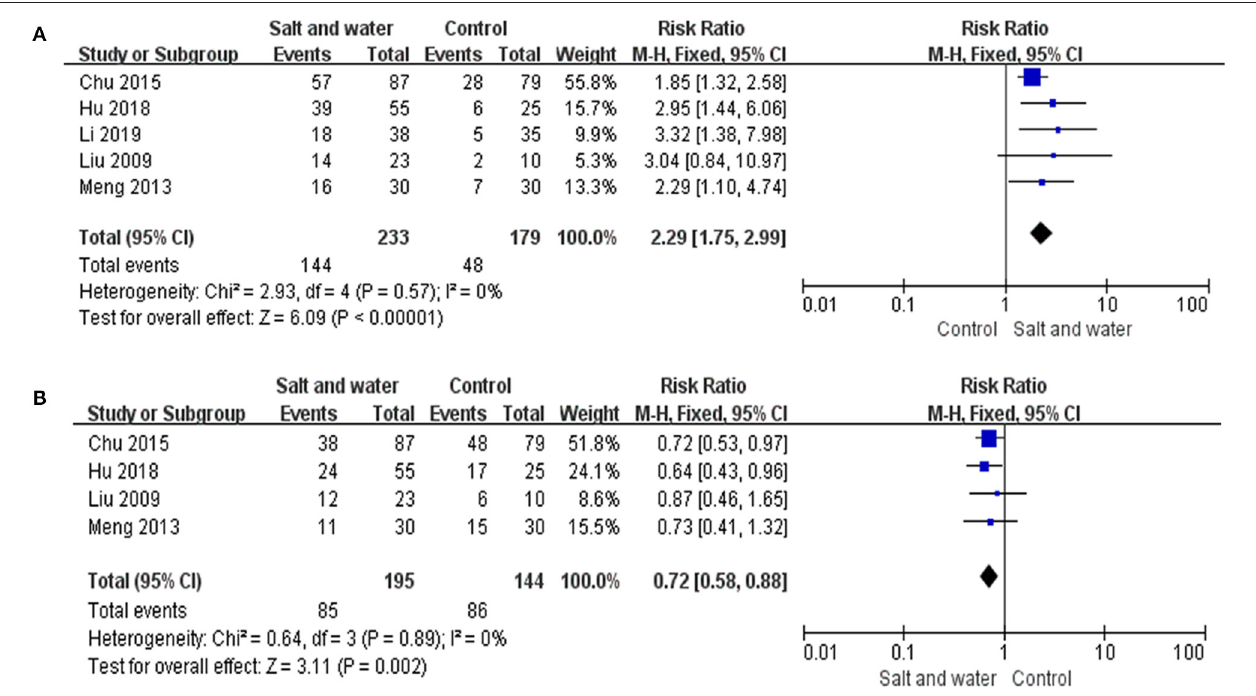
FIGURE 4 | Forest plot of the studies. (A) Forest plot of the studies evaluating therapeutic efficacy of increased salt and water intake with the negative changing rate of HUTT. (B) Forest plot of the studies evaluating the therapeutic efficacy of increased salt and water intake with syncope or presyncope recurrence rate. Heterogeneity analysis showed no conspicuous heterogeneity among the above studies, and a fixed-effect model was adopted. The RR results analyzed by the M-H test are summarized on the right. The RR and its 95% CI of each study are represented by small squares and transverse lines, respectively, and the rhombus below represents the overall results of the meta-analysis. RR, risk ratio; CI, confidence interval; M-H, Mantel-Haenszel